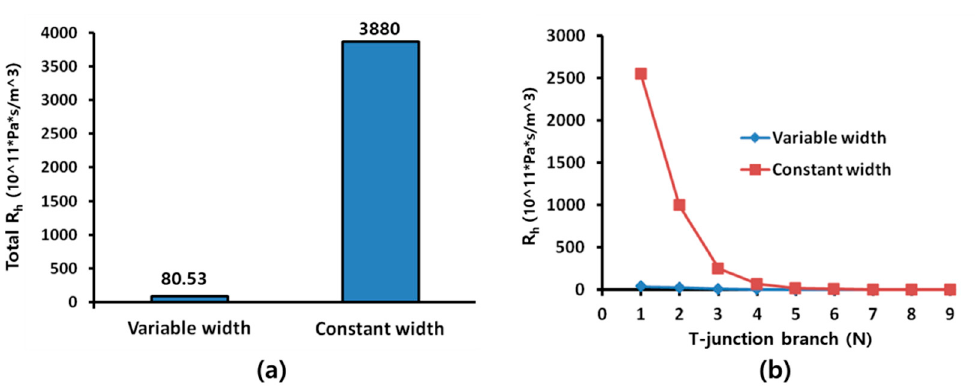
Figure 3. Comparison of the analytical R h values of a microchannel with variable width and the analytical R h values of a microchannel with a constant width at a T-junction branch: ( a ) total R h of T-junction branch; ( b ) R h at each T-junction.